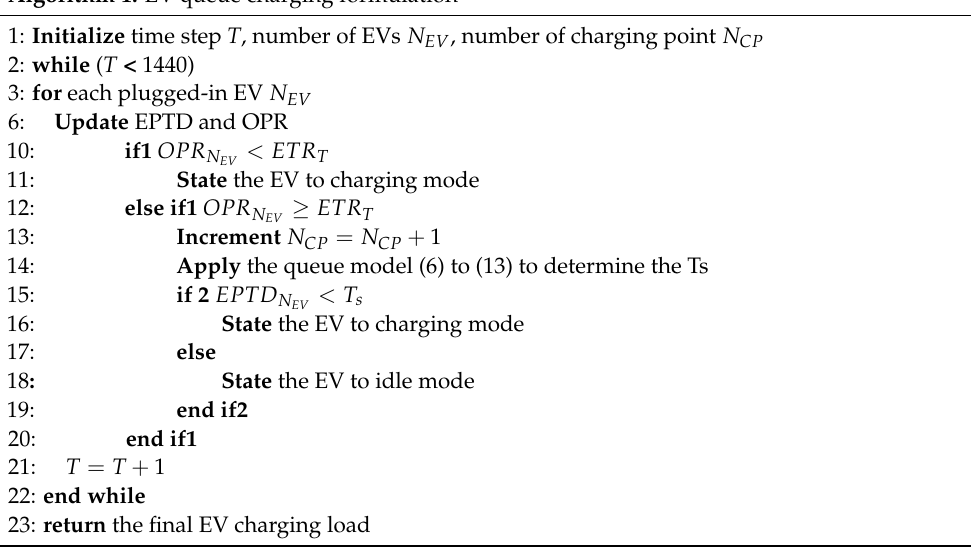
Figure 4. Real-time ETR with the owner reference price. Algorithm 1: EV queue charging formulation